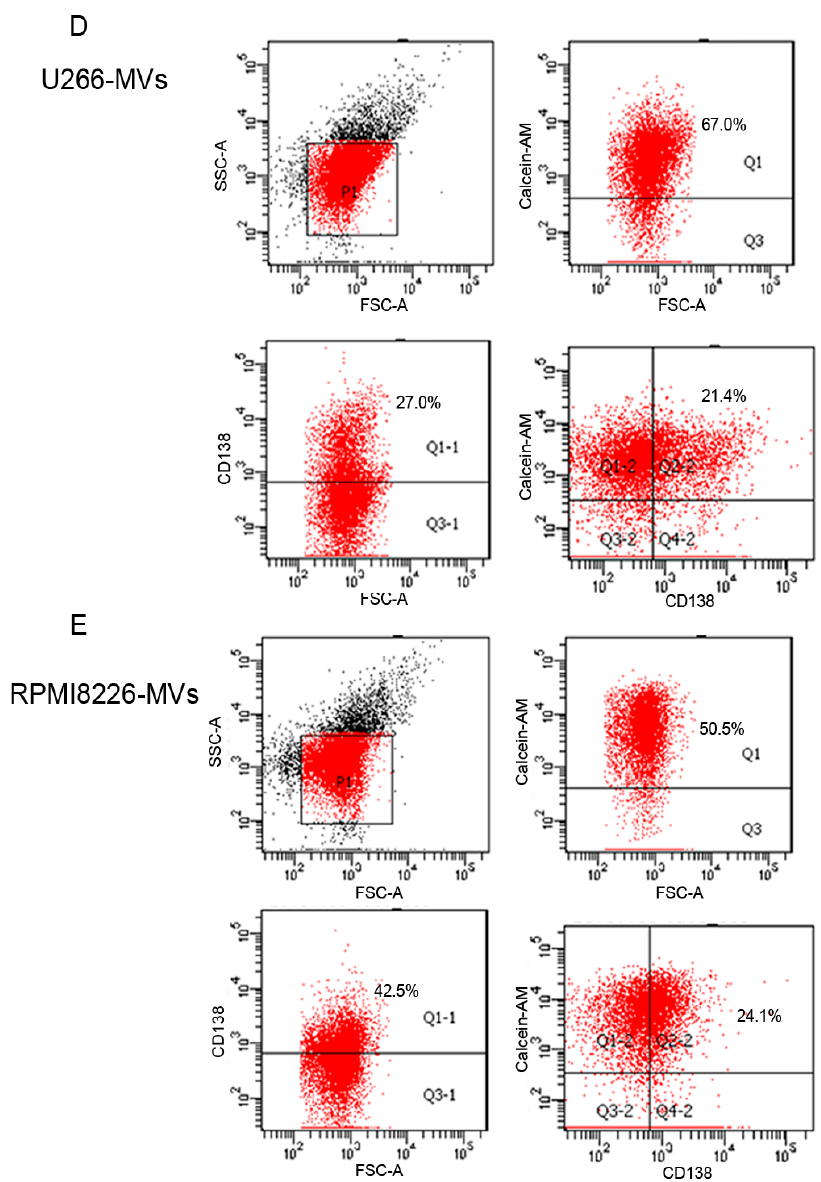
Figure 1. Characterization of myeloma cell-derived microvesicles (MM-MVs) ( A , B ) Transmission electron microscopy revealing MVs (arrow) as 100–1000 μ m vesicles shed from U266 cells (U266-MVs). Scale bar = 2 μ m ( A ) and 0.2 μ m ( B ); ( C ) Scanning electron microscopy showing typical morphology of MVs derived from RPMI8226 myeloma cells (RPMI8226-MVs). Scale bar = 2 μ m; ( D , E ) Representative flow cytometry analysis of U266-MVs and RPMI8226-MVs revealing the presence of CD138+Calcein-AM+ vesicles, with the 1 μ m microbeads for gating the MVs for size verification and Calcein-AM to detect the integrity of